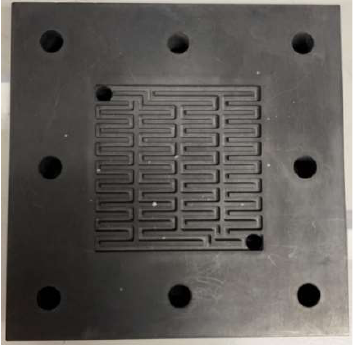
Figure 14. Flow field